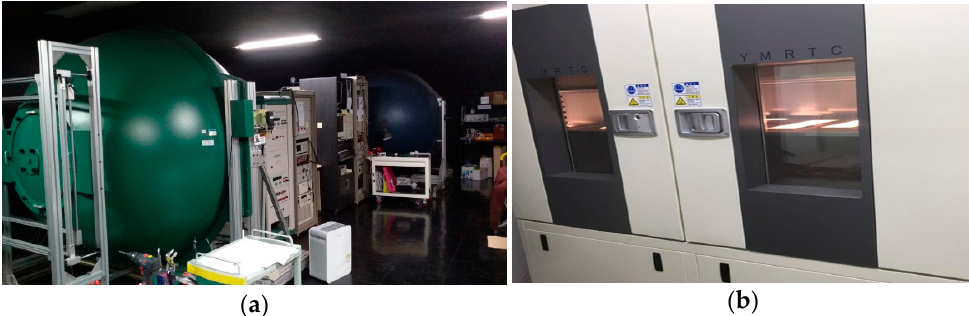
Figure 1. Experimental setup for operating OLED panels. ( a ) Integrating sphere measurement system for OLED products. ( b ) Operating conditions with fixed temperature in a chamber.